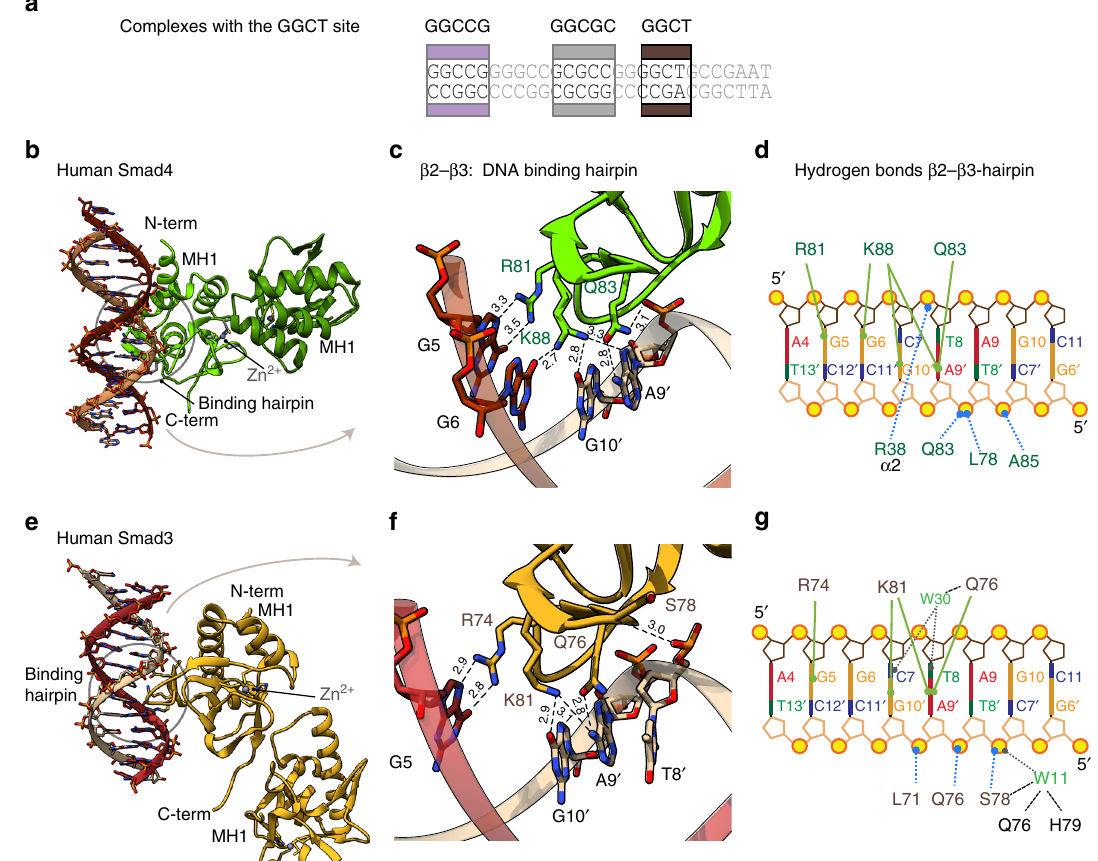
Fig. 5 Complex structures of the Smad4 and Smad3 MH1 domains with the GGCT site. a Schematic representation of the GC1 site. The GGCT DNA used for crystallization was TGCAGGCTAGCCTGCA and its location in the GC1 site is highlighted in dark brown. b Asymmetric unit of Smad4 complex with the GGCT motif. The ASU contains two Smad4 MH1 domains and one dsDNA. c Smad4 complex with the GGCT motif, as in Fig. 4c. Lys88 is displayed with two side chain orientations, as present in the different molecules of the ASU. d Intermolecular contacts for Smad3 complex with the GGCT motif, as in Fig. 4d. e Smad3 complex with the GGCT motif. The asymmetric unit of the complex contains two Smad3 MH1 domains and one dsDNA. f Smad3 complex with the GGCT motif, as in Fig. 4c. g Intermolecular contacts for Smad4 complex with the GGCT motif, as in Fig.